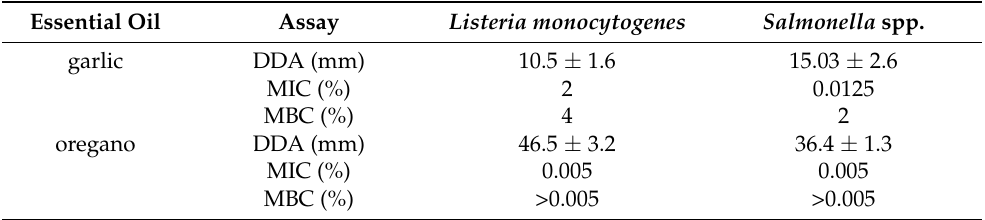
Table 3. Zones of growth inhibition (mm; mean ± standard deviation) with the DDA (disk diffusion assay), minimal inhibitory concentration (MIC) and minimal bactericide concentration (MBC) of garlic and oregano essential oils against Salmonella spp. and L. monocytogenes